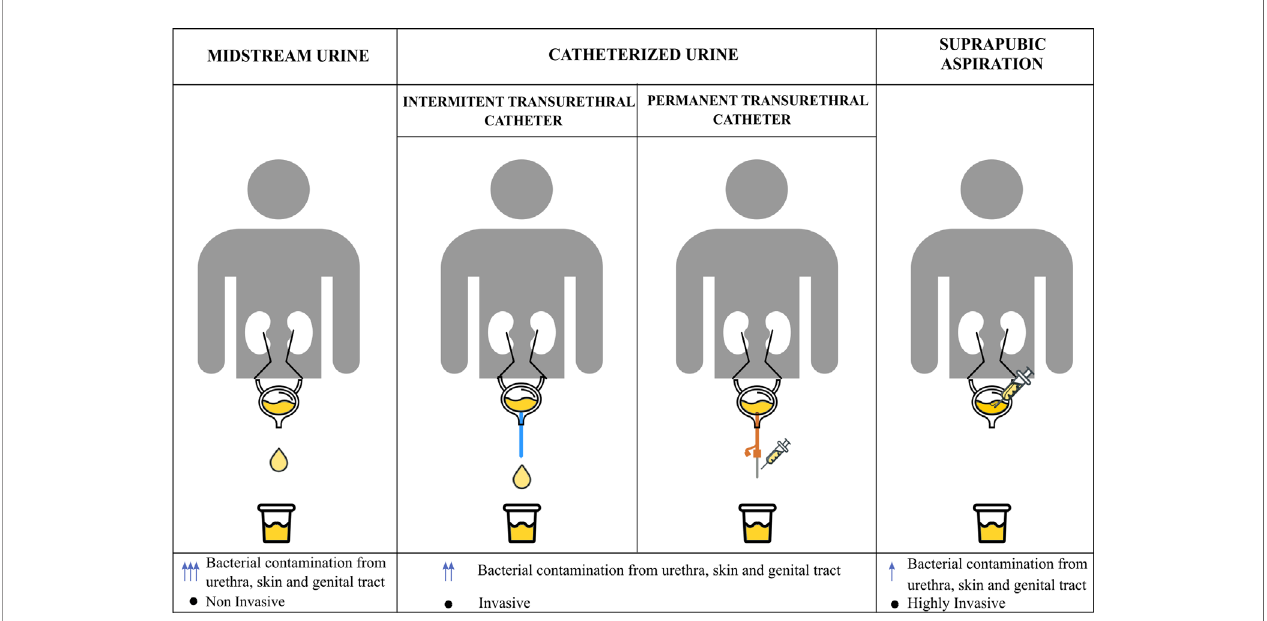
FIGURE 2 | Collection methods for urine samples. Urine samples can be collected by different methods: collection of spontaneous midstream urine, catheterization with an intermittent or permanent catheter or suprapubic aspiration from the bladder. Differences between these methods lie in the grade of possible bacterial contamination from other areas such as the urethra, the skin or the genital apparatus, and the grade of invasion in each technique. The number of arrows indicates the grade of contamination depending on the collection method